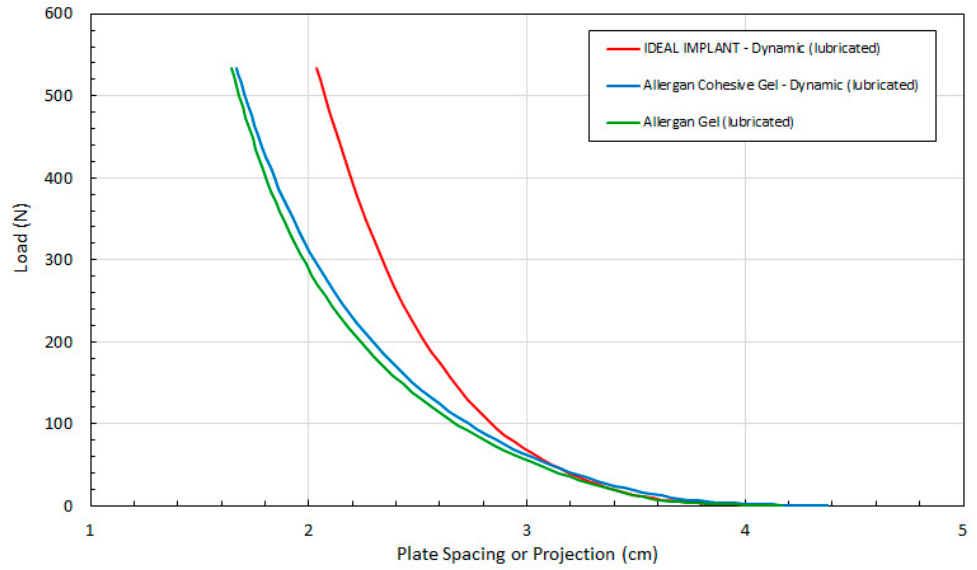
Figure 7. Load (F) as a Function of Plate Spacing (H) for Dynamic Testing and Lubricated Platens.